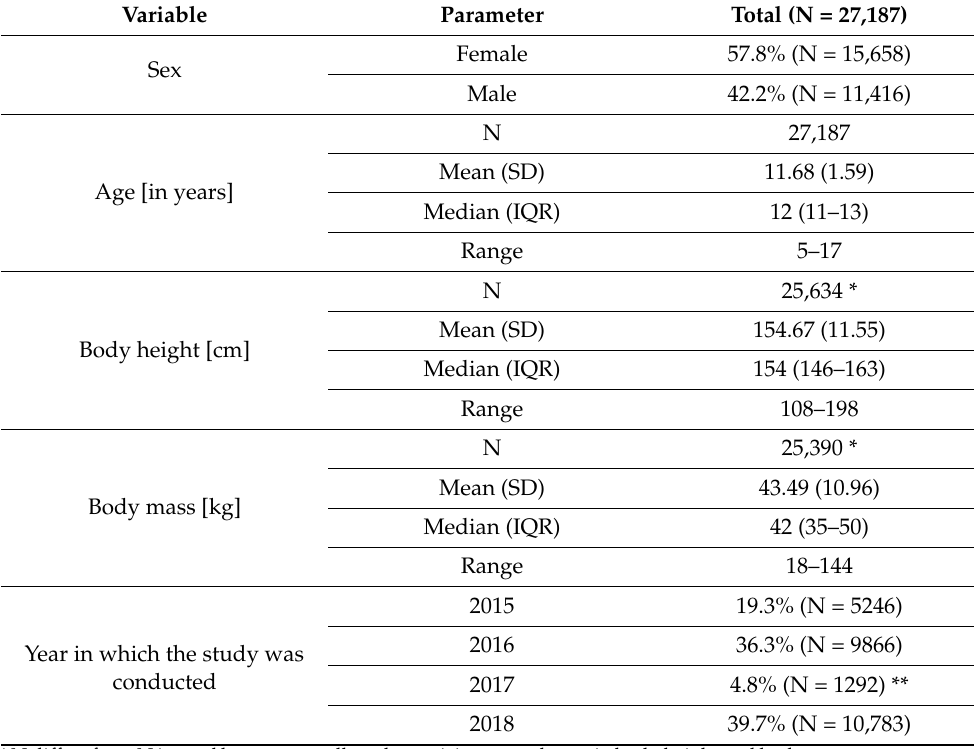
Table 1. Characteristics of the studied